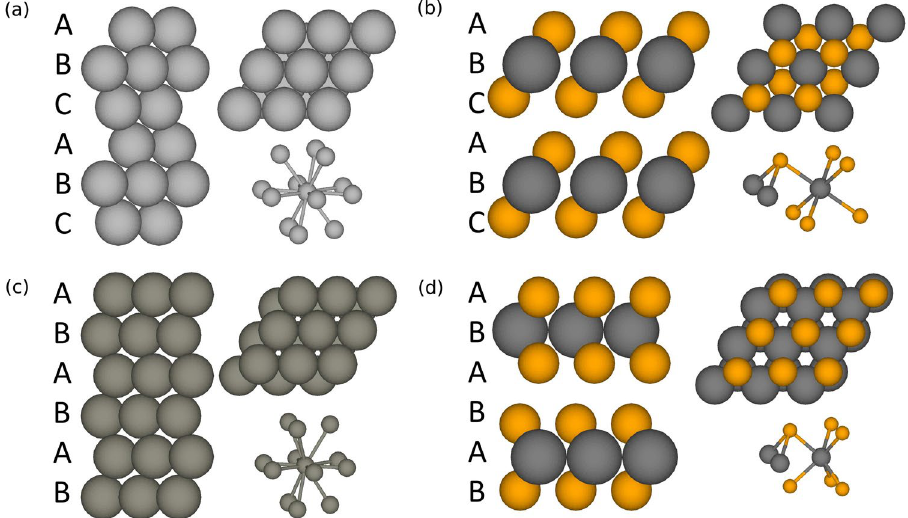
Figure 1. Side view (left), top view (up-right) and the neighboring environment (right-bottom) of ( a ) an fcc metal, ( b ) a 1T-TMD, ( c ) an hcp metal and ( d ) a 2H-TMD. The figure shows that the stacking of the atomic layers in a TMD resembles that in a closest packing metal, but different in the sequence of the elements and the interlayer and interatomic distances.